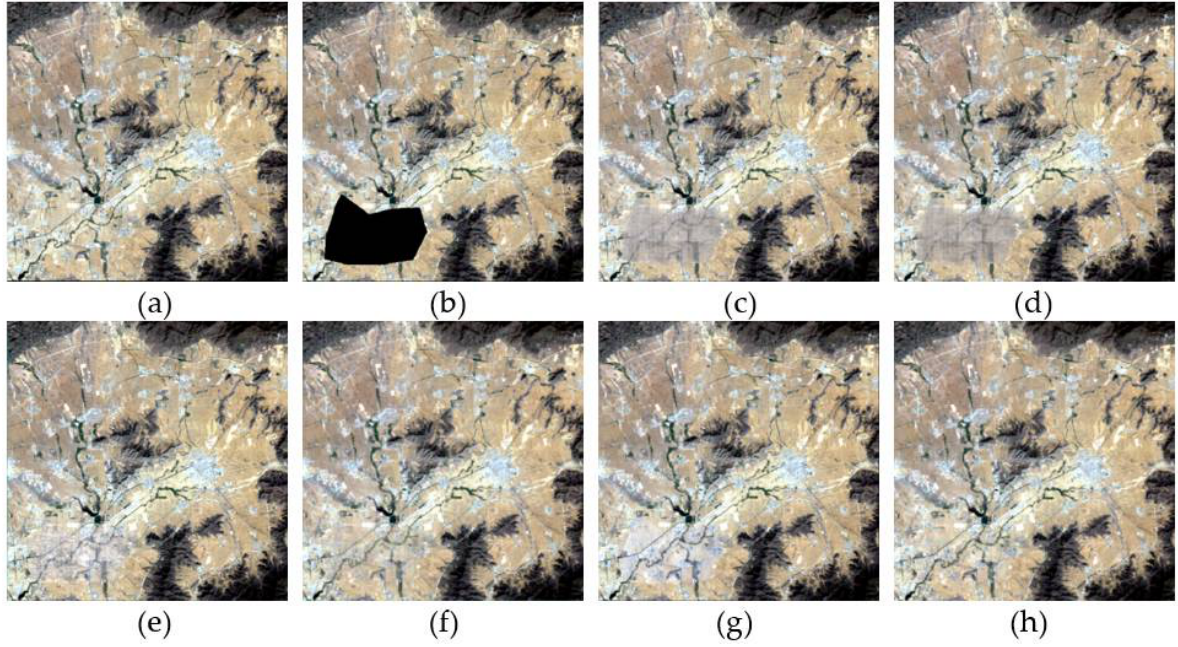
Figure 7. The simulated experiment performed on dataset 2: ( a ) original image; ( b ) simulated cloudy image; ( c – h ) reconstructed images with HaLRTC, AWTC, NL-LRTC, TVLRSD, ST-Tensor and FMTC algorithms, respectively.